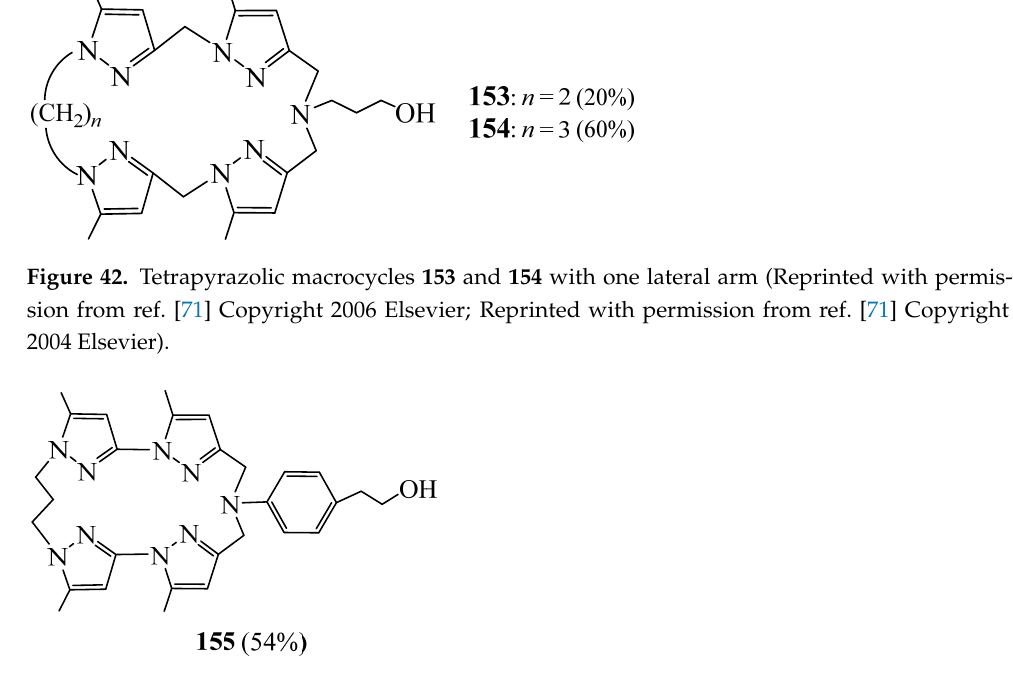
Figure 43. Tetrapyrazolic macrocycles 155 with one aromatic lateral arm.